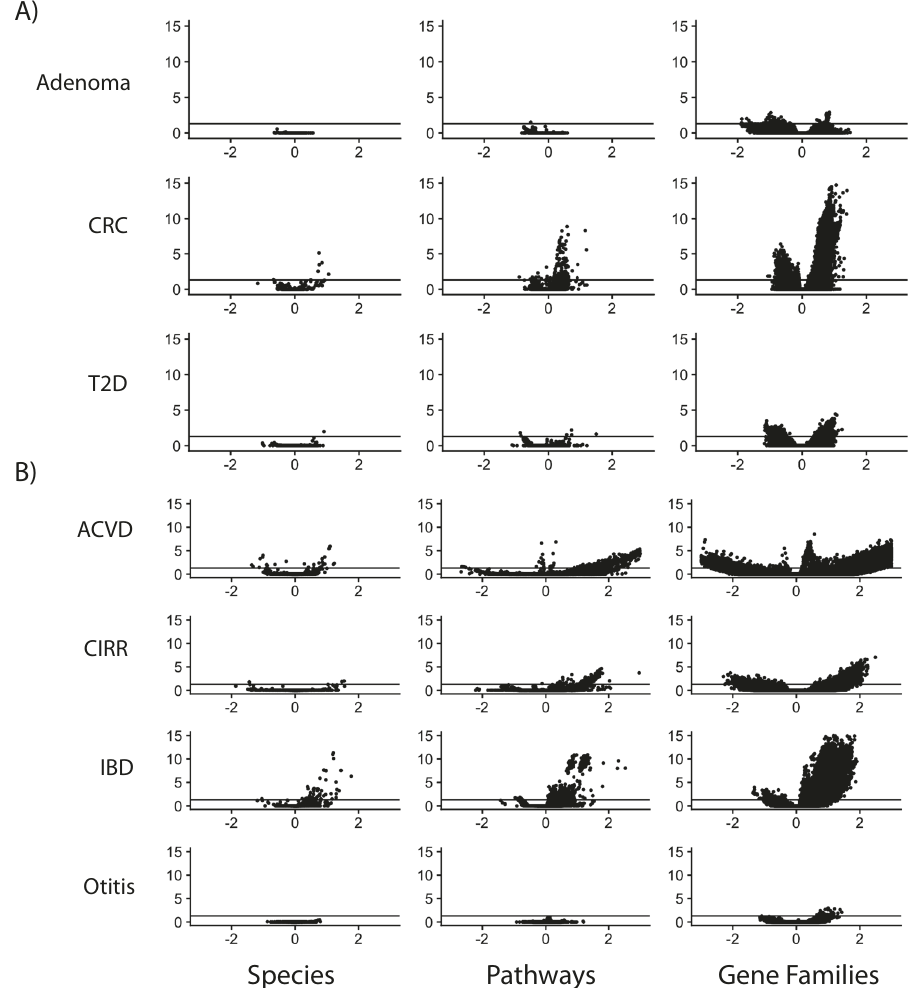
Fig. 2 Initial association output. Initial association outputs for each A meta-analyzed and B single-cohort phenotype, split by species associations, pathway associations, and gene family associations. Each point represents a different feature (e.g., species). Y axes are false-discovery rate-adjusted log 10 P values. Solid line is false-discovery rate-adjusted statistical signi fi cance ( P < 0.05). X axes are the beta-coef fi cient on the binary, independent disease variable of